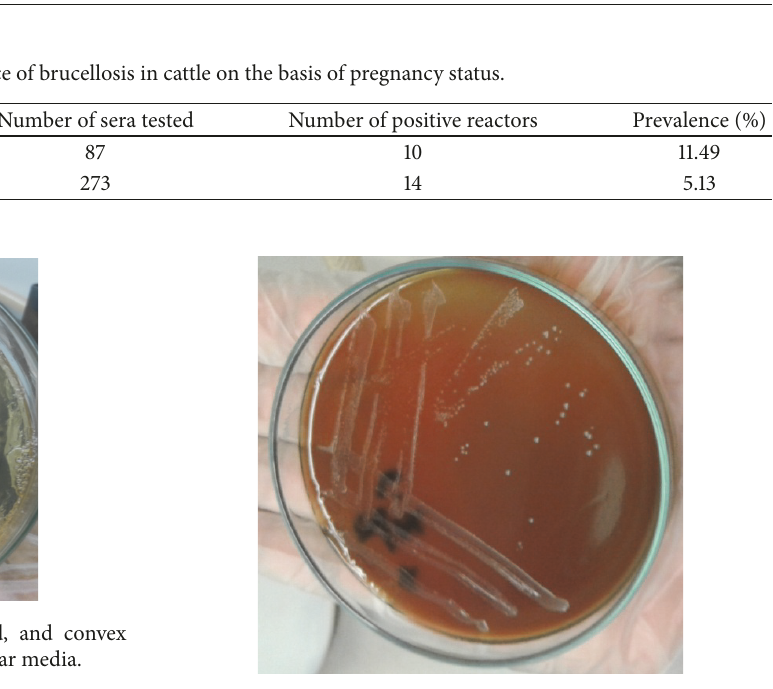
Figure 3: Whitish-grey, shiny, circular, convex, and nonhemolytic colonies of bacteria on blood agar media.